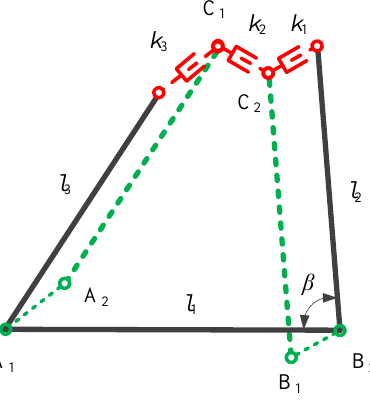
Figure 5. Equivalent β after vector translations.